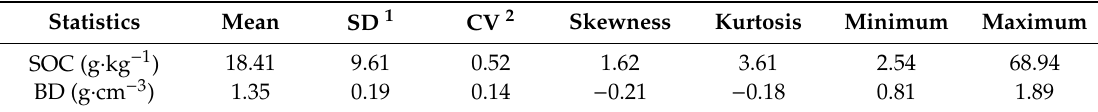
Table 3. Descriptive statistics values of SOC and bulk density (BD) at the sampling sites.